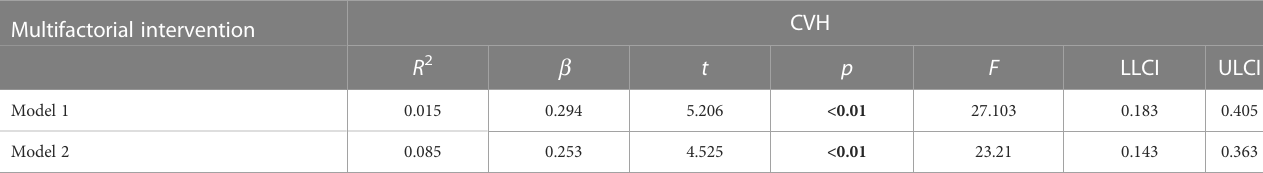
TABLE 4 The multilevel linear regression between CVH and multifactorial intervention (behavioral, diet, and drug treatment). Multifactorial intervention CVH R 2 b t p F LLCI ULCI Model 1